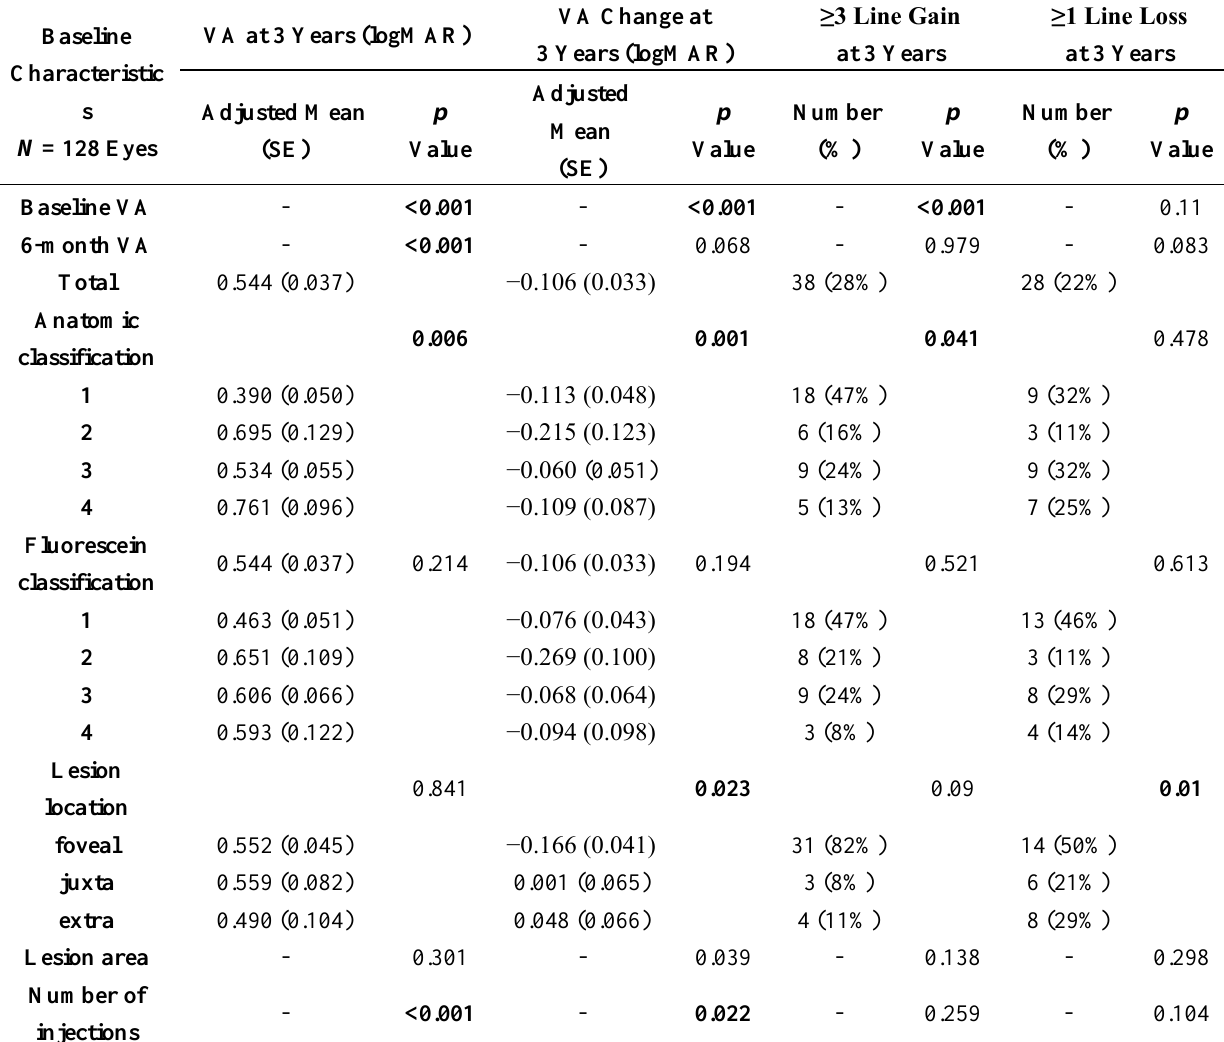
Table 1. Bivariate associations of baseline clinical characteristics and visual parameters at 3 years.